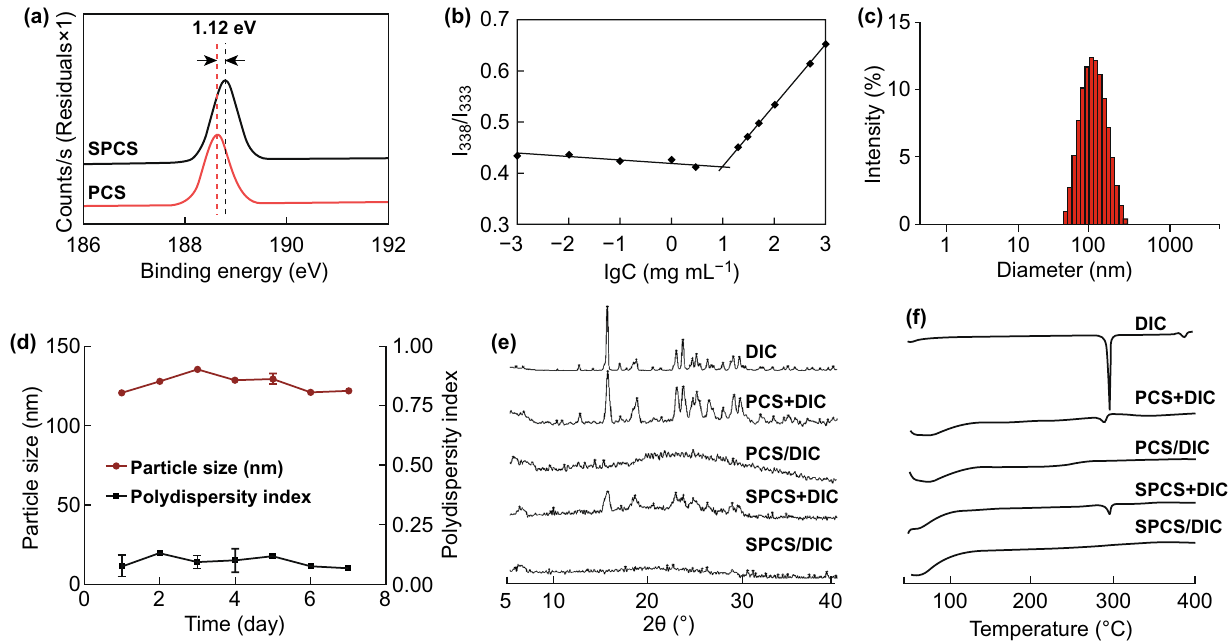
Figure 2 Physicochemical property and DIC-encapsulating capacity of SPCS micelles. a XPS spectra of PCS and SPCS. b Fluorescence inten- sity ratio ( I 337 / I 332 ) plot of pyrene versus logarithm of SPCS concentration (Log C) at pH 7.4. c The hydrodynamic particle size distribution of SPCS/DIC micelles measured by DLS. d Changes in diameter and PDI of SPCS/DIC micelles at 4 °C within a week. e XRD patterns, and f DSC curves of DIC, PCS + DIC physical mixture, PCS/DIC micelles, SPCS + DIC physical mixture and SPCS/DIC